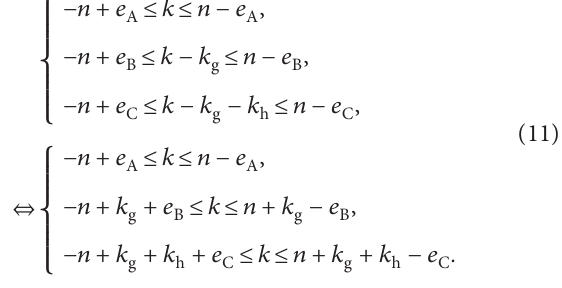
3.1. Fault Detection. Figure 10 illustrates V , c_cellHA3 KH signals, T 1 and T 2, and fault signal of HA3 in cellHA3 simulation. Before 0.1 s, the system operates normally and fault signal equals 0. Due to deadtime and measurement delay, T appears, but the T 1 counter is used for delay avoiding error in detection. T 2 counter resets the algo- rithm after 2 ms period. After 0.1 s S 1 switch of HA3 faces the problems, measured V is different from c_cellHA3 KH , T 1 starts to count and the fault is detected after cellHA3 1 ms, fault signal equals 1, and HA3 is removed from the system. Figure 11 describes fault signal of HA3, HB1, HB3, and HB5. Open-circuit problems on phase B appear at 0.2 s, according to the scenario shown in Table 6. The algorithm can detect the problem at any position and can be applied for multiple cells at the same time.